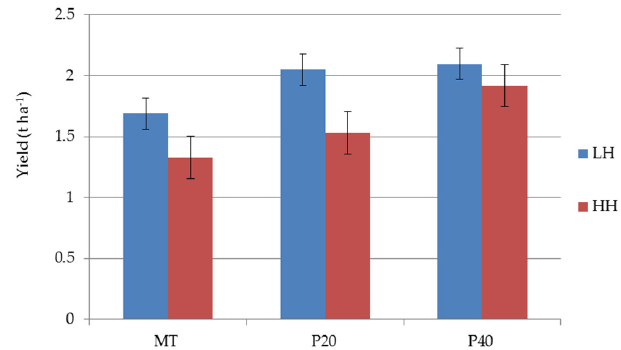
Figure 5. Results of wheat harvesting (Error bars represent the standard deviation. Average of 18 values).